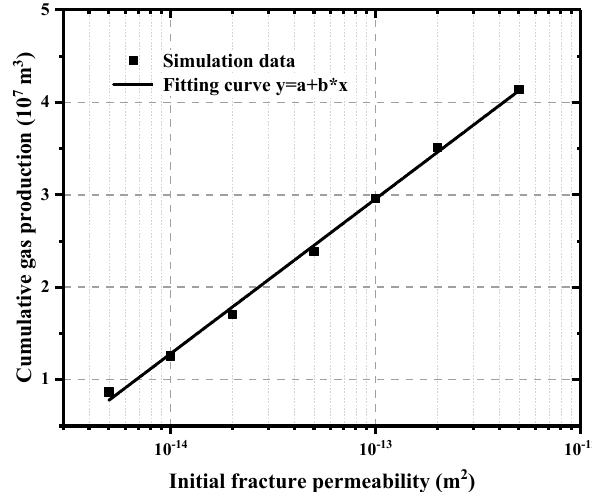
Figure 12. Linear relationship between cumulative gas production and initial fracture permeability.